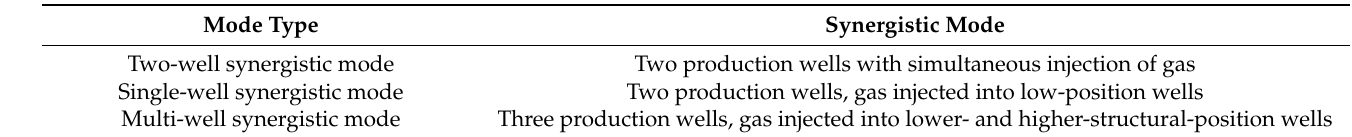
Table 4. Synergistic mode of CO 2 huff and puff.